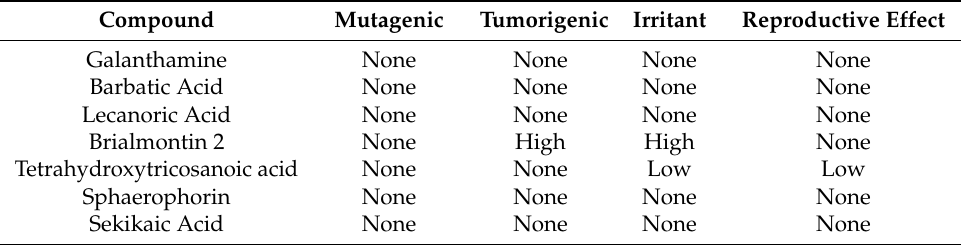
Table 8. Calculation of toxicity risks of compounds in the extracts of Lecania brialmontii, Pseudephebe pubescens and Sphaerophorus globosus in comparison with the standard inhibitor galanthamine on acetylcholinesterase (TcAChE) and butyrylcholinesterase (hBChE) obtained from Osiris Data Warrior software.